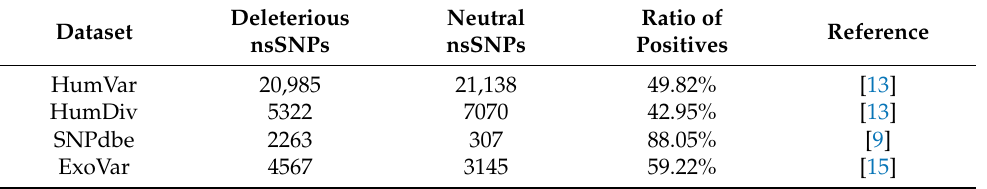
Table 1. Summary of the benchmark datasets used in this